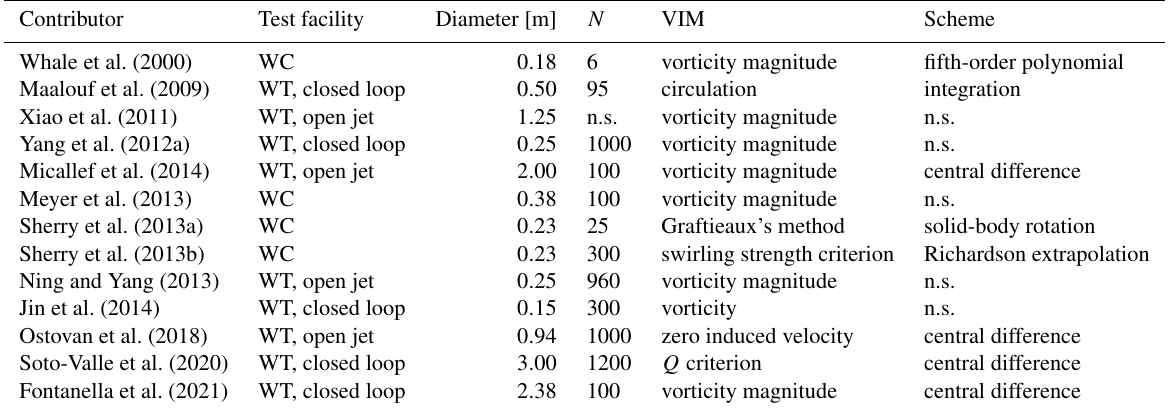
Table 1. Wind turbine tip vortices studies employing the PIV technique and VIM details.